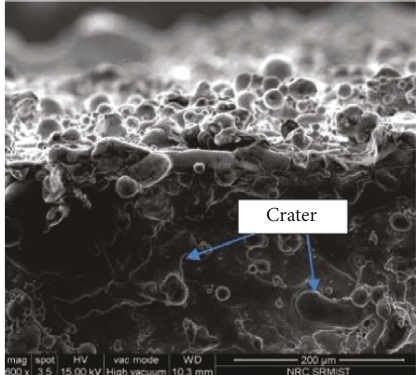
Figure 5: Machined surface using heat-treated brass tool with 600x magnification.